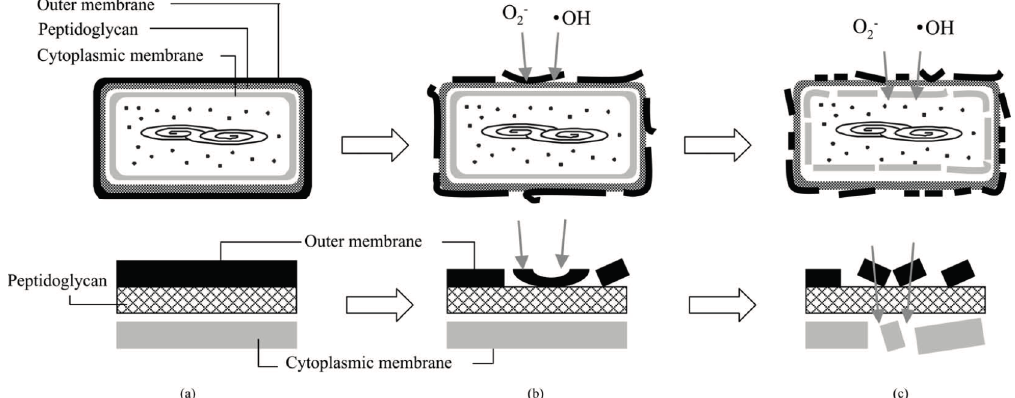
Figure 3. ( a – c ) Schematic illustration of the process of E. coli inactivation on photo-excited TiO 2 . In the lower row, the part of cell envelope is magnified. (Reproduced from Sunada, K.; Watanabe, T.; Hashimoto, K. Studies on photokilling of bacteria on TiO 2 thin film. J. Photoch. Photobio A 2003 , 156 , 227–233